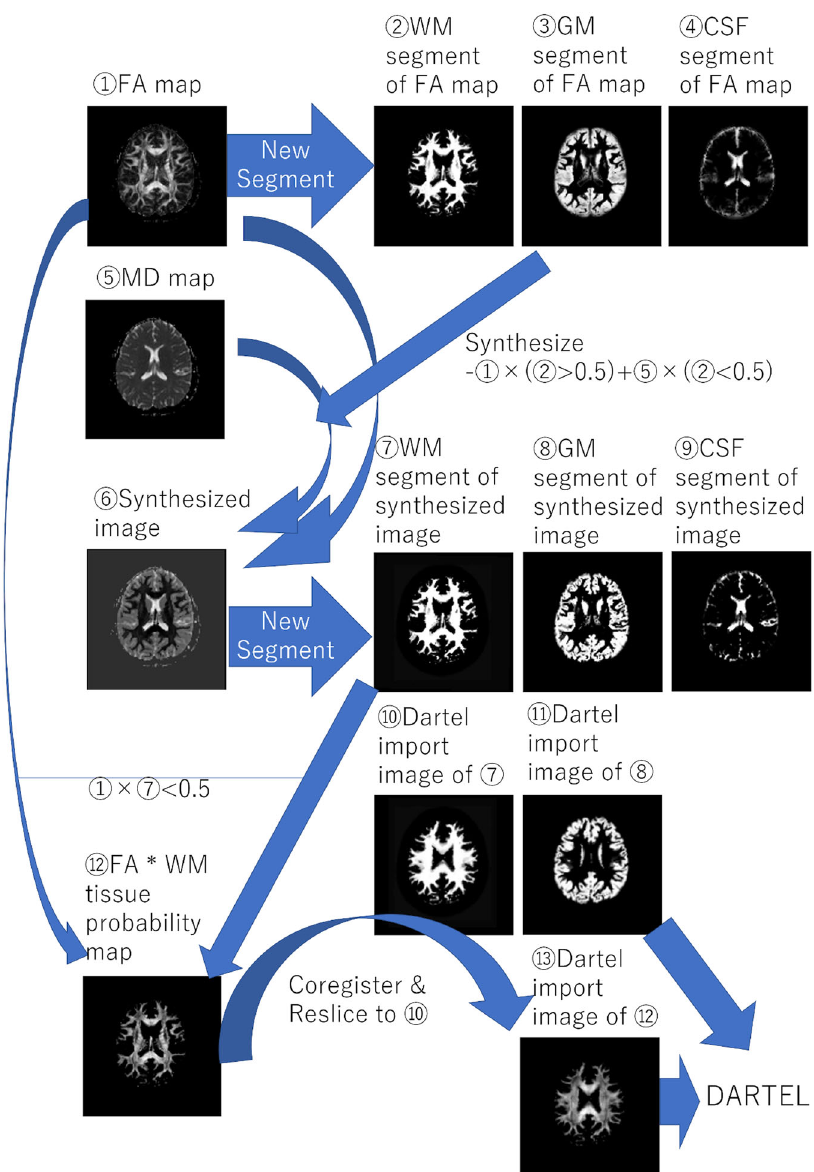
Fig. 9 Diffusion images. A scheme of the preprocessing procedure of diffusion